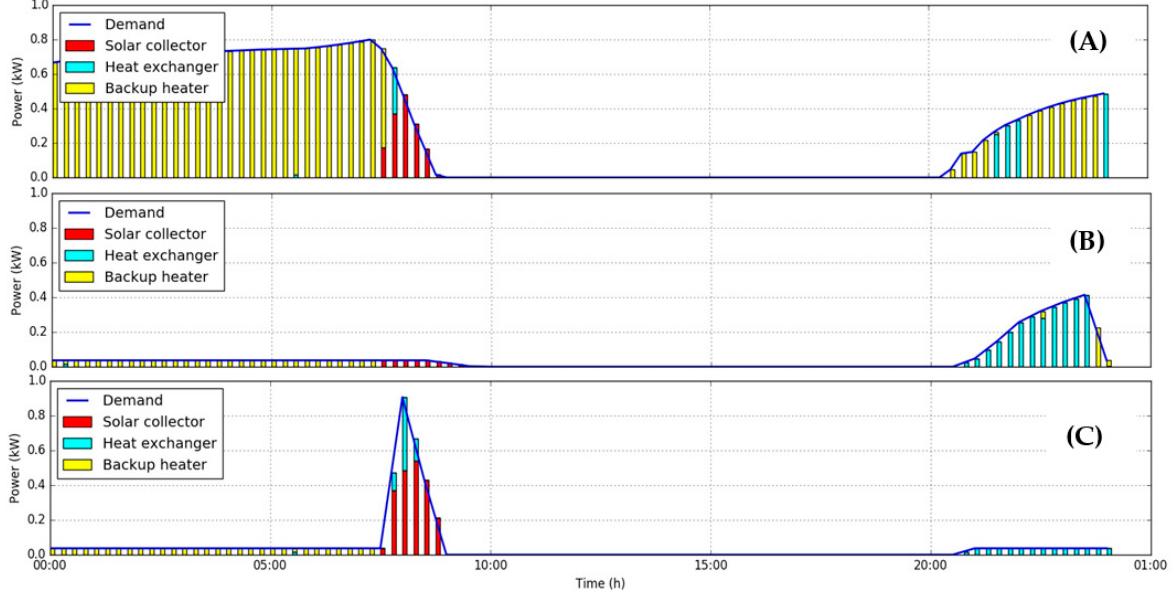
Figure 18. Demand profiles and sources of energy used to ensure comfort in ( A ) services, ( B ) domestic, and ( C ) office buildings [147].